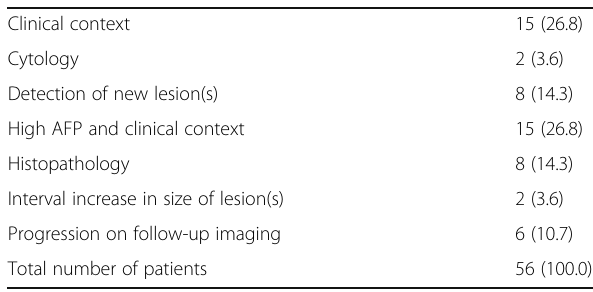
Table 3 Corroboration of lesion(s) seen on FDG PET CT, n